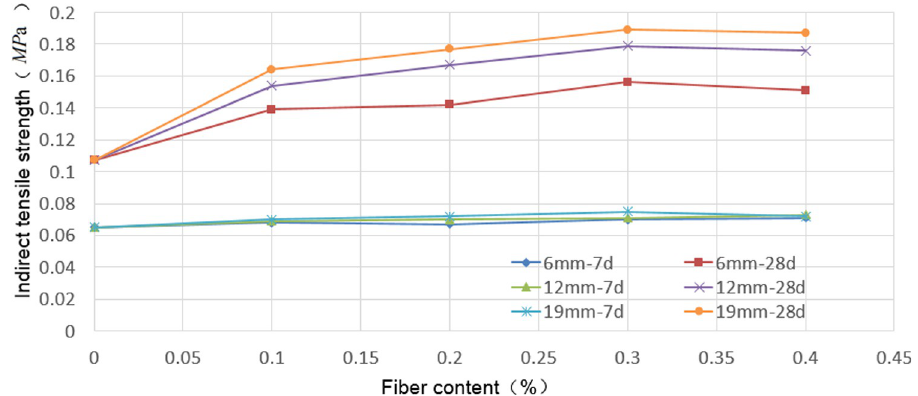
Fig 9. Results of indirect tensile strength test. For the same fiber length and content, the indirect tensile strength of the solidified soil significantly increased with increasing curing time. With an increase in the fiber length for the same fiber content, the indirect tensile strength of the 7 d solidified soil did not increase significantly; in contrast, the indirect tensile strength of the 28 d solidified soil increased significantly.